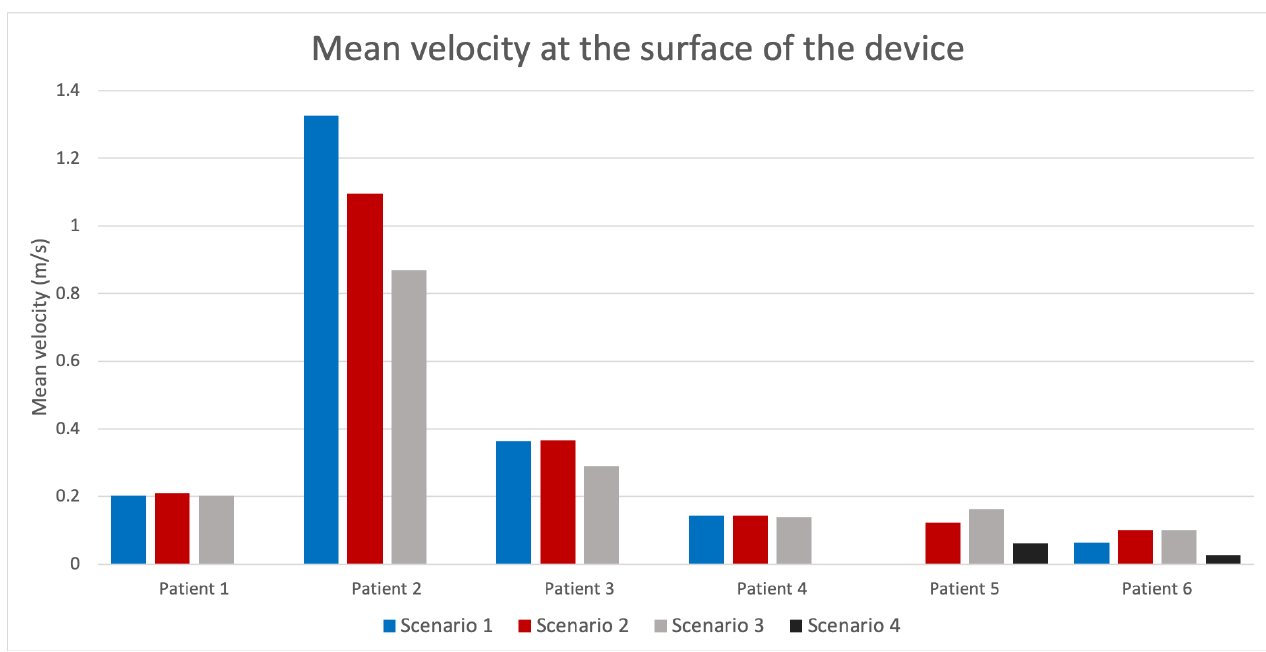
Figure 4. Average blood flow velocities near the device surface for the different simulated scenarios in all analysed patients. Pat 1–3 and Pat 4–6 were without and with device-related thrombus, respectively. Missing bars in some patients indicate simulation